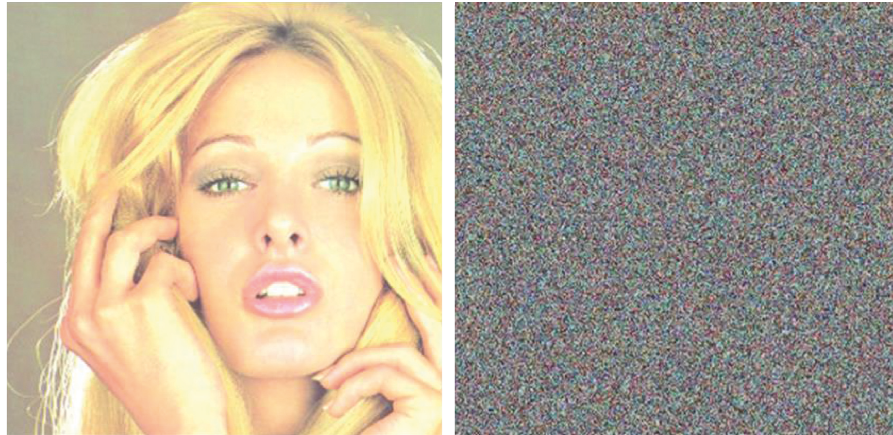
Figure 10: Tiffany’s image and its cipher image.